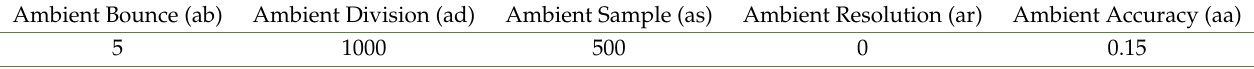
Table 3. Radiance ambient settings